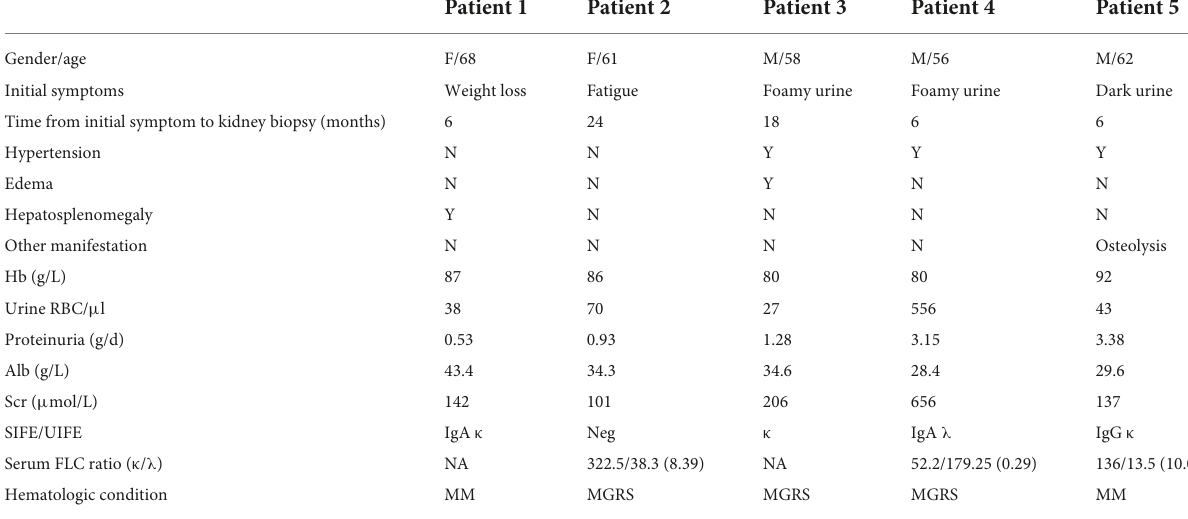
TABLE 1 Demographics and clinical characteristics.